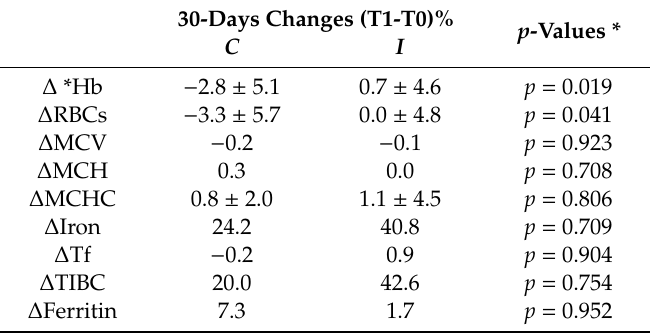
Table 3. The percentage change from baseline of biochemical markers of martial status in patients over / equal 65 years old randomized to control group (C, n = 23) or treatment group (I, n = 22) with 30 mg of sucrosomial ferric pyrophosphate and 70 mg of L-ascorbic acid daily during 30 days prior to hip or knee surgery. 30-Days Changes (T1-T0)% p -Values *